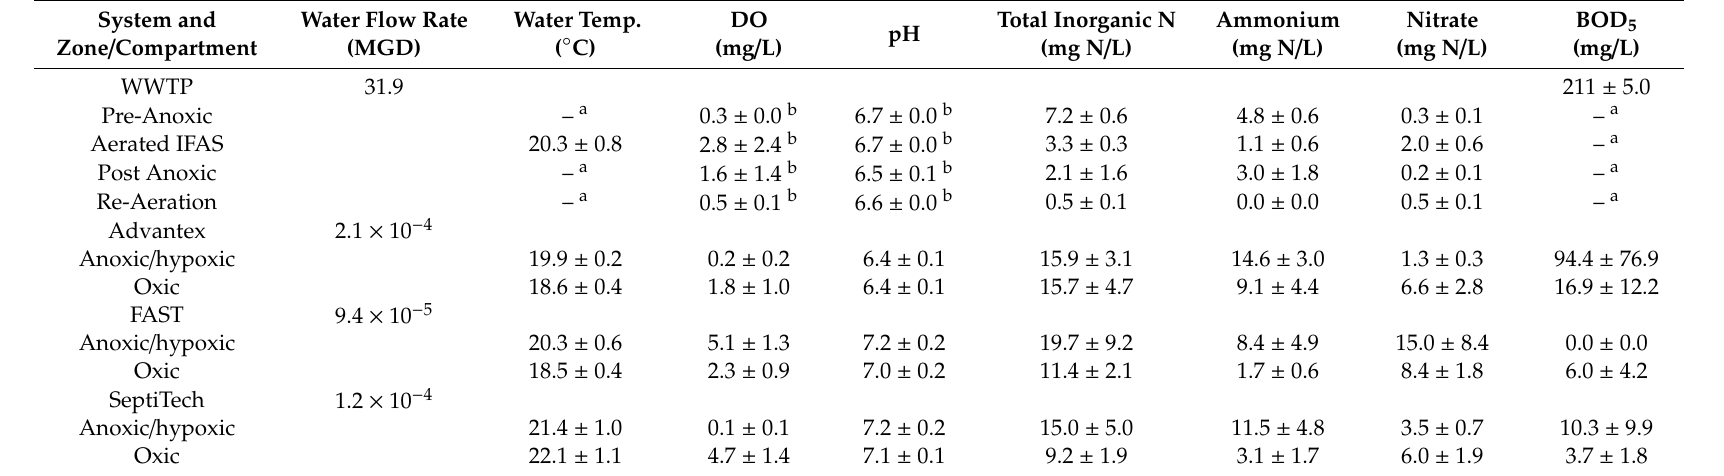
Table A1. Average and standard error of wastewater properties from pre-anoxic, aerated Integrated Fixed Film Activated Sludge (IFAS), post anoxic, and re-aeration zones in the wastewater treatment plant and anoxic / hypoxic and oxic zones in Advantex, FAST, and SeptiTech (onsite wastewater treatment systems). Table and methods for collection originally published in Brannon et al.